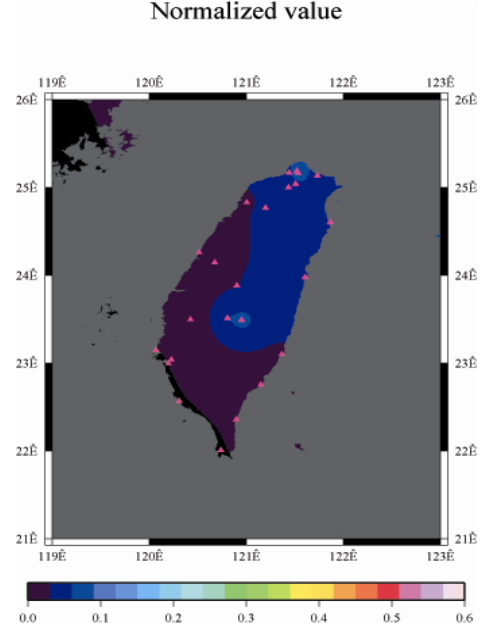
Figure 13. Normalized rainfall values around the island before the typhoon struck Taiwan (September 13th, 2008, 3:00 PM).